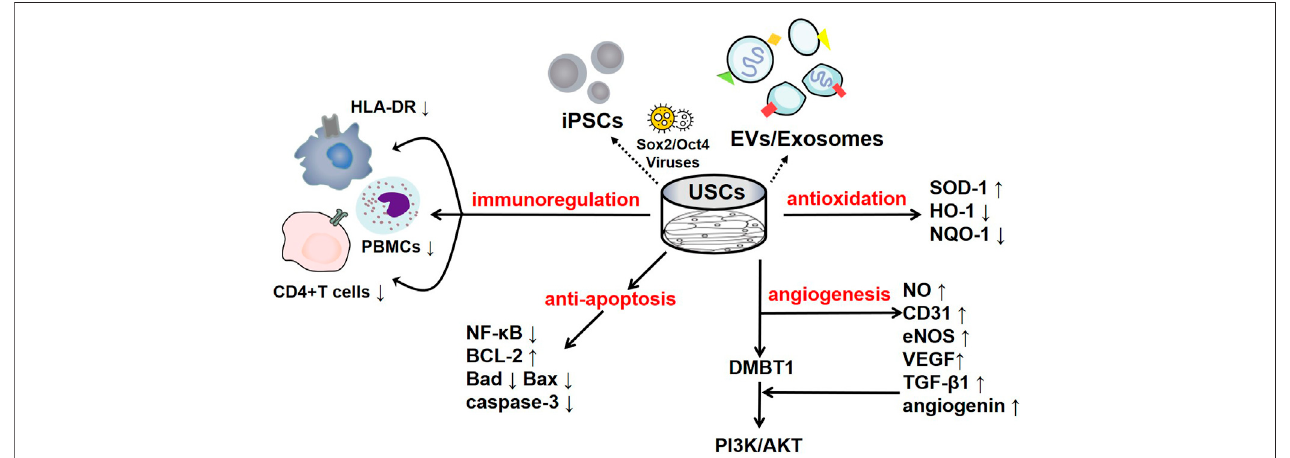
FIGURE 1 | The regulatory mechanisms of USCs and their secreted products. USCs and their secreted products, such as exosomes, extracellular vesicles, and USC-iPSCs, play an important role in disease the pathogeneses. USCs exert negative immunoregulatory functions and serve as antioxidants, as manifested by their increased SOD-1 levels and reduced HO-1 levels. USCs exert an antiautophagic effect, characterized by increased p62 levels and decreased levels of LC3-II and Beclin1. Furthermore, USCs promote angiogenesis mediated by VEGF, angiogenin, and PI3K/AKT pathway activation. Interestingly, their effect on apoptosis remains controversial, as they exhibit increased levels of the apoptotic protein Bax and decreased levels of the antiapoptotic protein